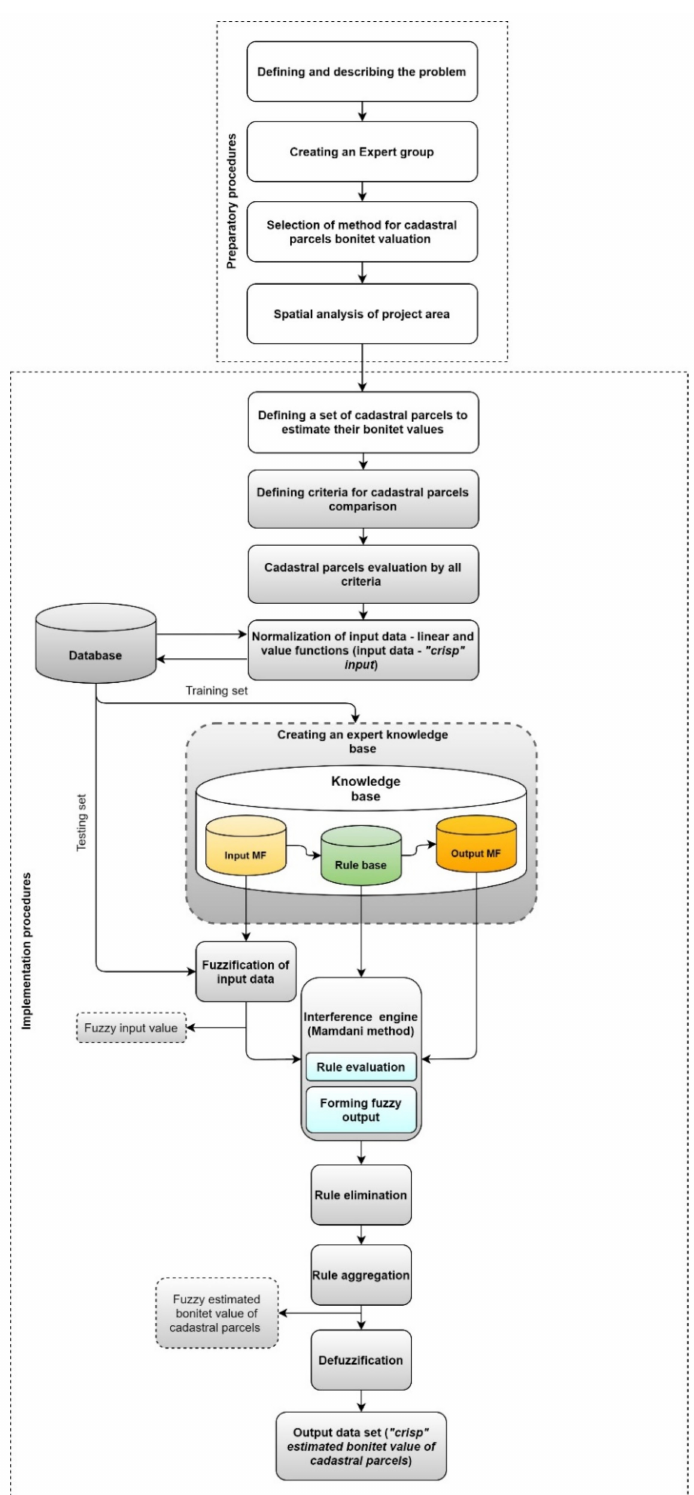
Figure 3. Model to assess the private cadastral parcels